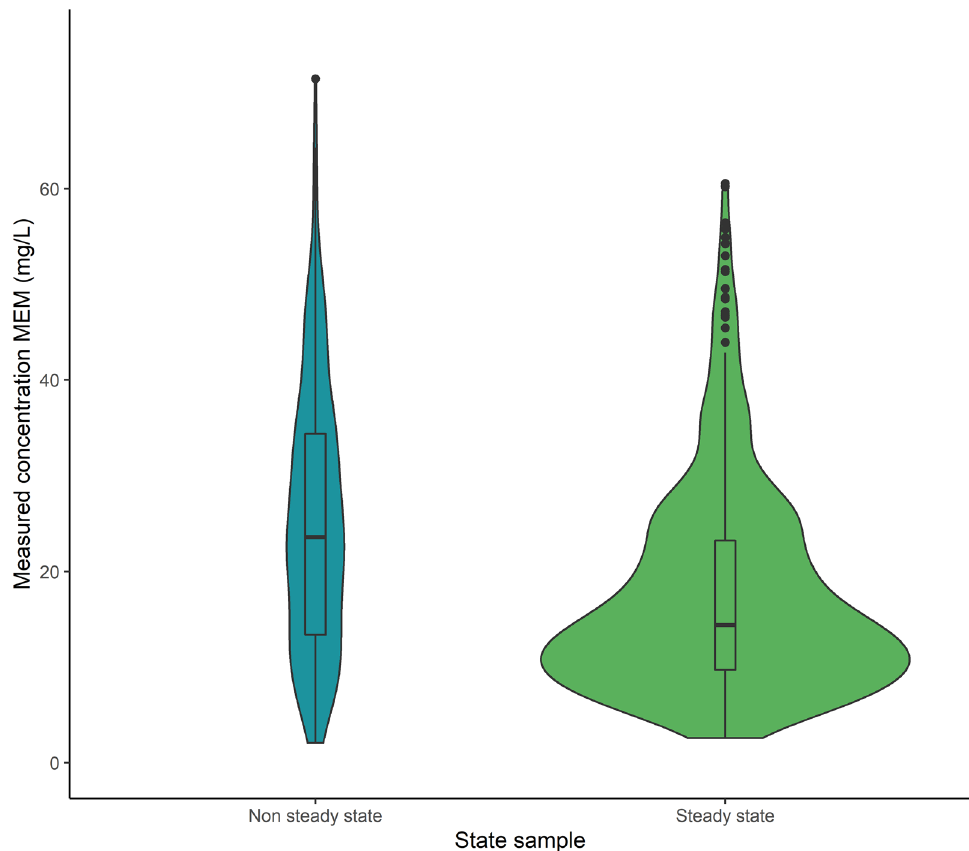
Fig. 6 Violin plot of free MEM concentrations according to sample state ( p =